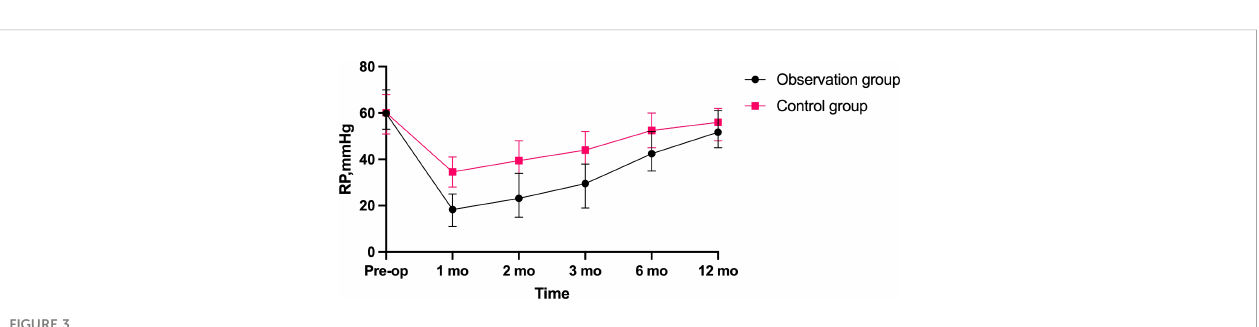
FIGURE 3 Comparison of resting pressure (RP) changes in anal canal between two